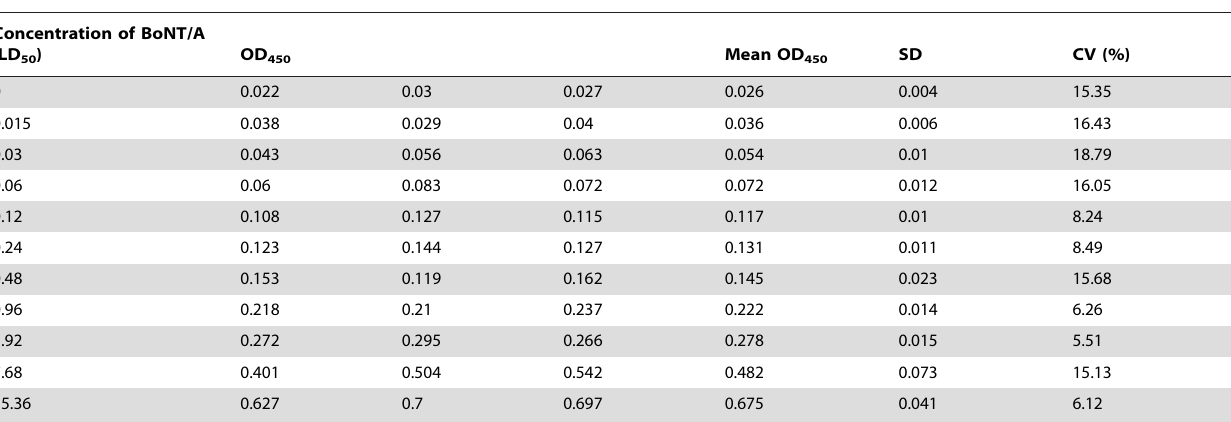
Table 1. Detection of BoNT/A with different concentration by anti-subA IgY.